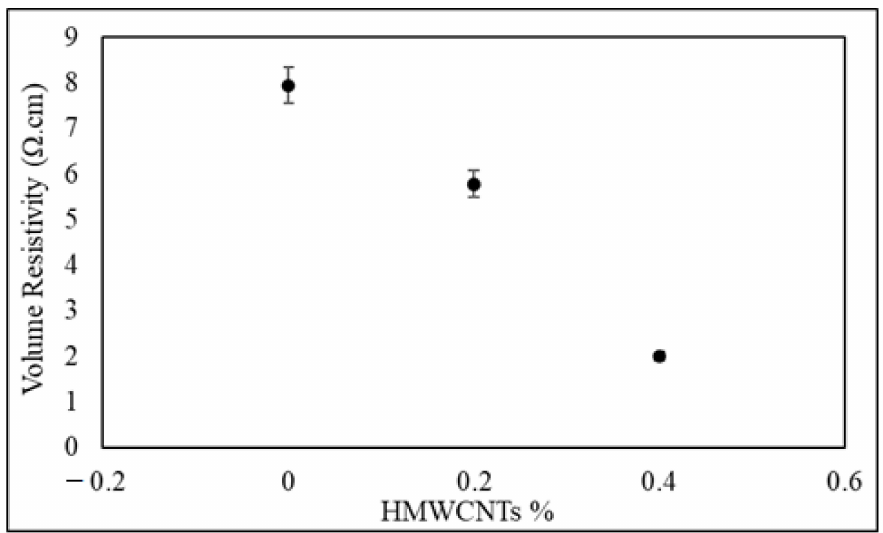
Figure 13. Volume resistivity of 0 wt.%, 0.2 wt.%, and 0.4 wt.%